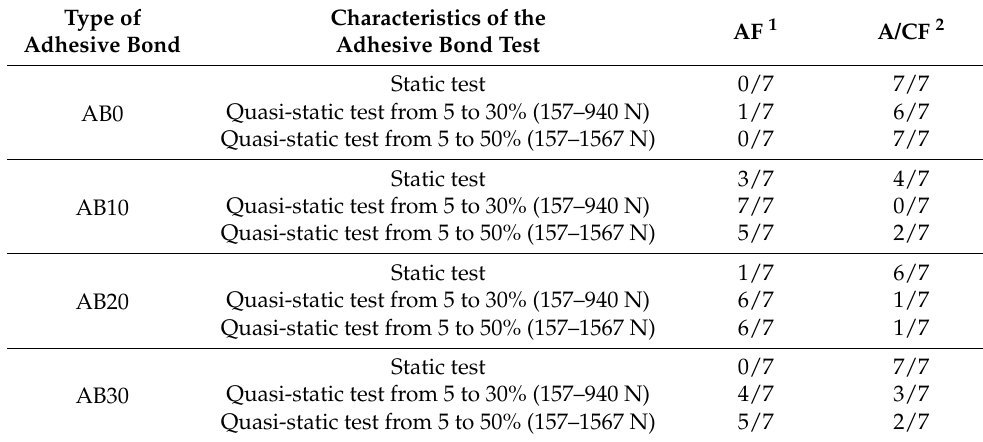
Table 4. Evaluation of the type of failure of individual types of adhesive